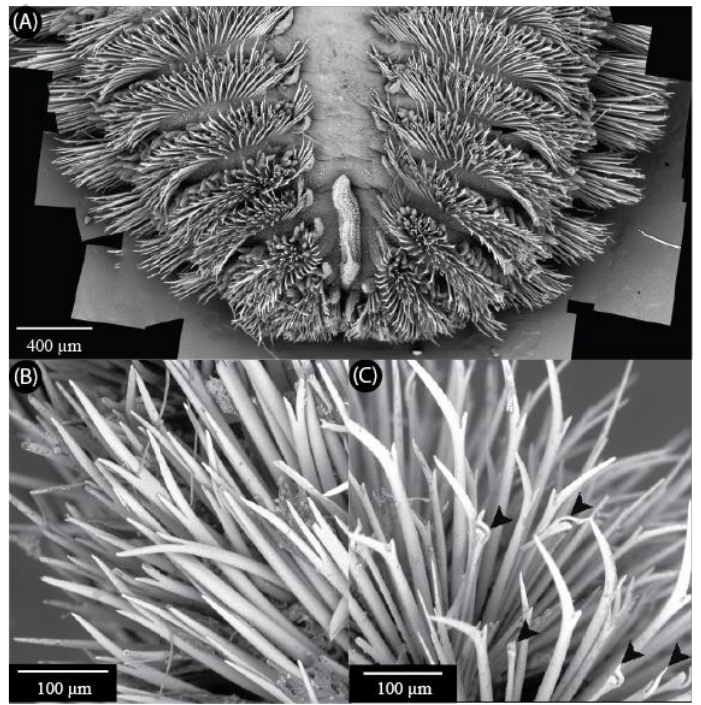
Figure 1. SEM images showing chaetae of Euphrosinidae species. ( A ) Euphrosine aurantiaca anterior end showing organization of chaetae on the body and caruncle. Image is a composite of several SEM photos generated in Microsoft Image Composite Editor. ( B ) Euphrosine sp. indet. (DZMB-HH 43974-A) with distally forked chaetae. ( C ) Euphrosinopsis sp. indet. (DZMB-HH 50004-K) with distally forked and ringent chaetae. Ringent chaetae are indicated by arrowheads.